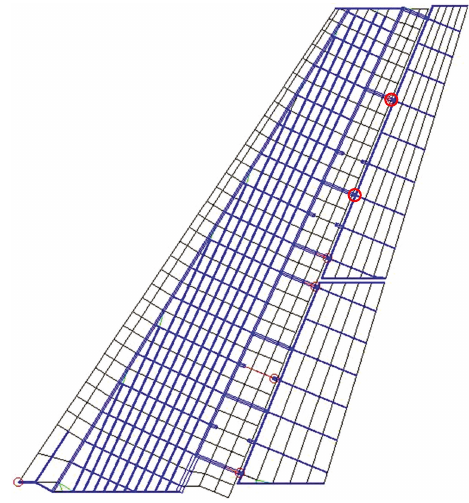
Figure 12: Wing-aileron connection in Case